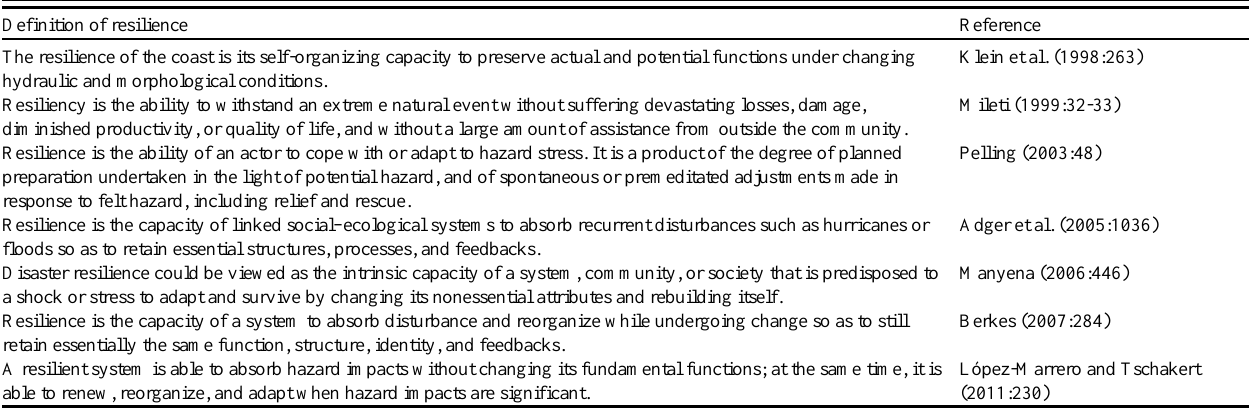
Table 3 . Some existing definitions of community resilience, without emphasizing recovery.